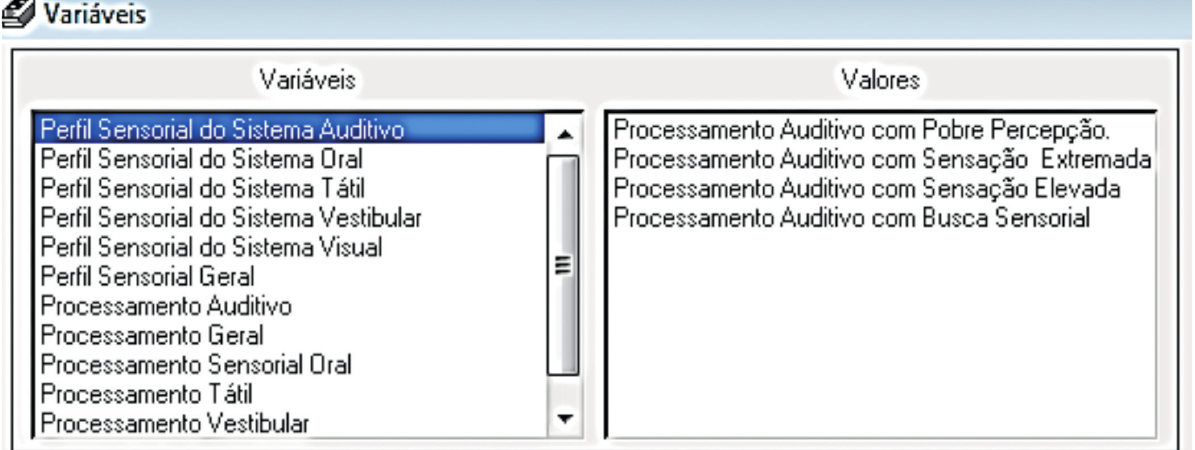
Figure 1 - Definition of variable auditory processing’s domain